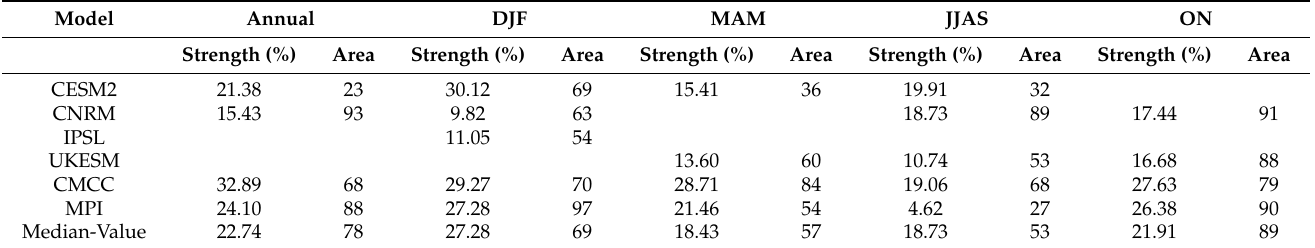
Table 2. Strength of atmospheric feedback (%). The values represent the robust cooling areas and strength refers only to cooling. The unit of area is in % relative to the total robust grid cells respective to the temporal